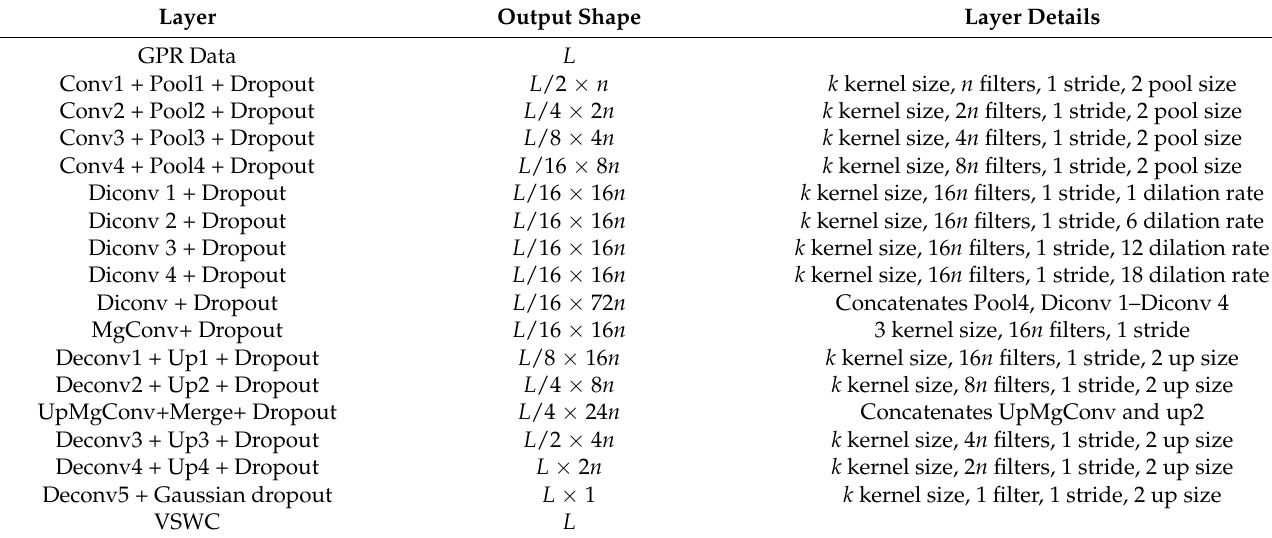
Table 1. Detailed information about the GPRSW